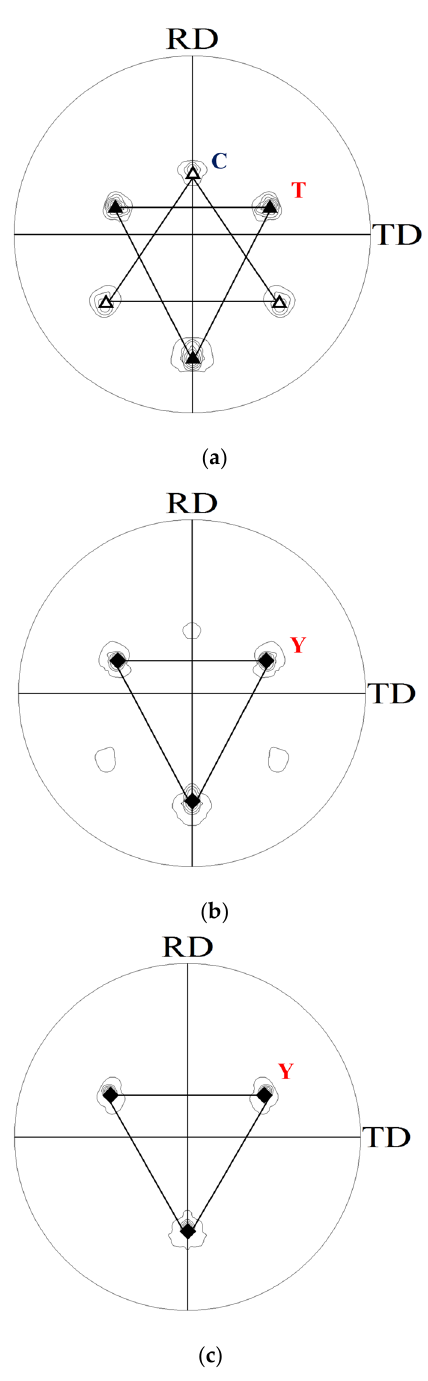
Figure 7. The {1 1 1} pole figures of fcc metals simulated using MTCS-model with single C orienta- tion after the reduction ratios of ( a ) 30%, ( b ) 60%, and ( c ) 90%. △ , ▲ , and ◆ are the pole positions on {1 1 1} pole figure of the orientation close to C (1 1 2)[1(cid:3364) 1(cid:3364) 1] , T (5 5 2)[1 1 5(cid:3364)] , and Y (1 1 1)[1 1 2(cid:3364)] , respectively.